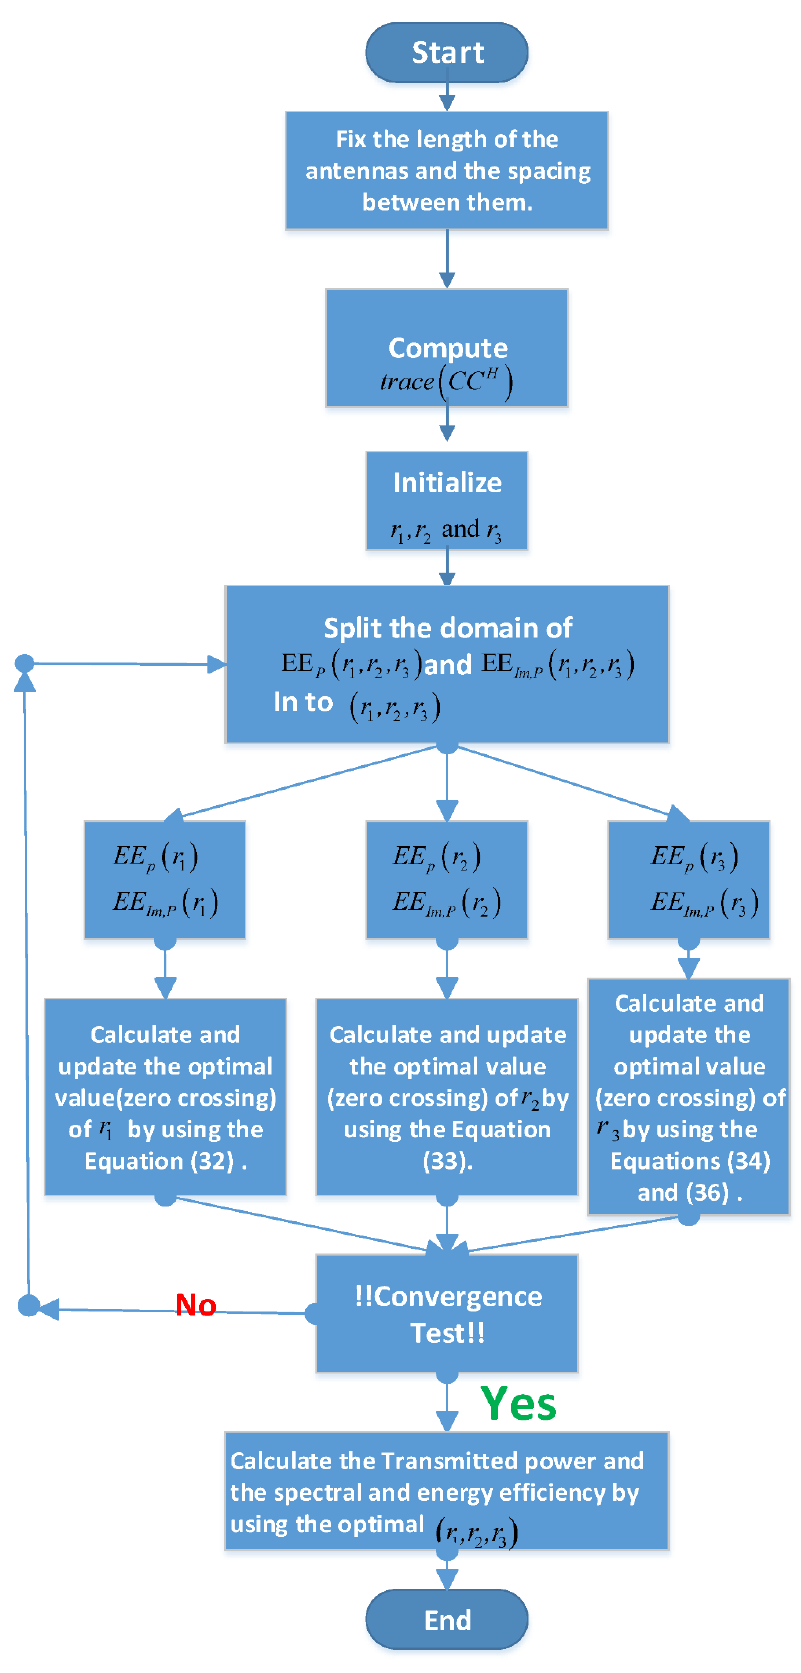
Figure 3. Domain Splitter Algorithm.